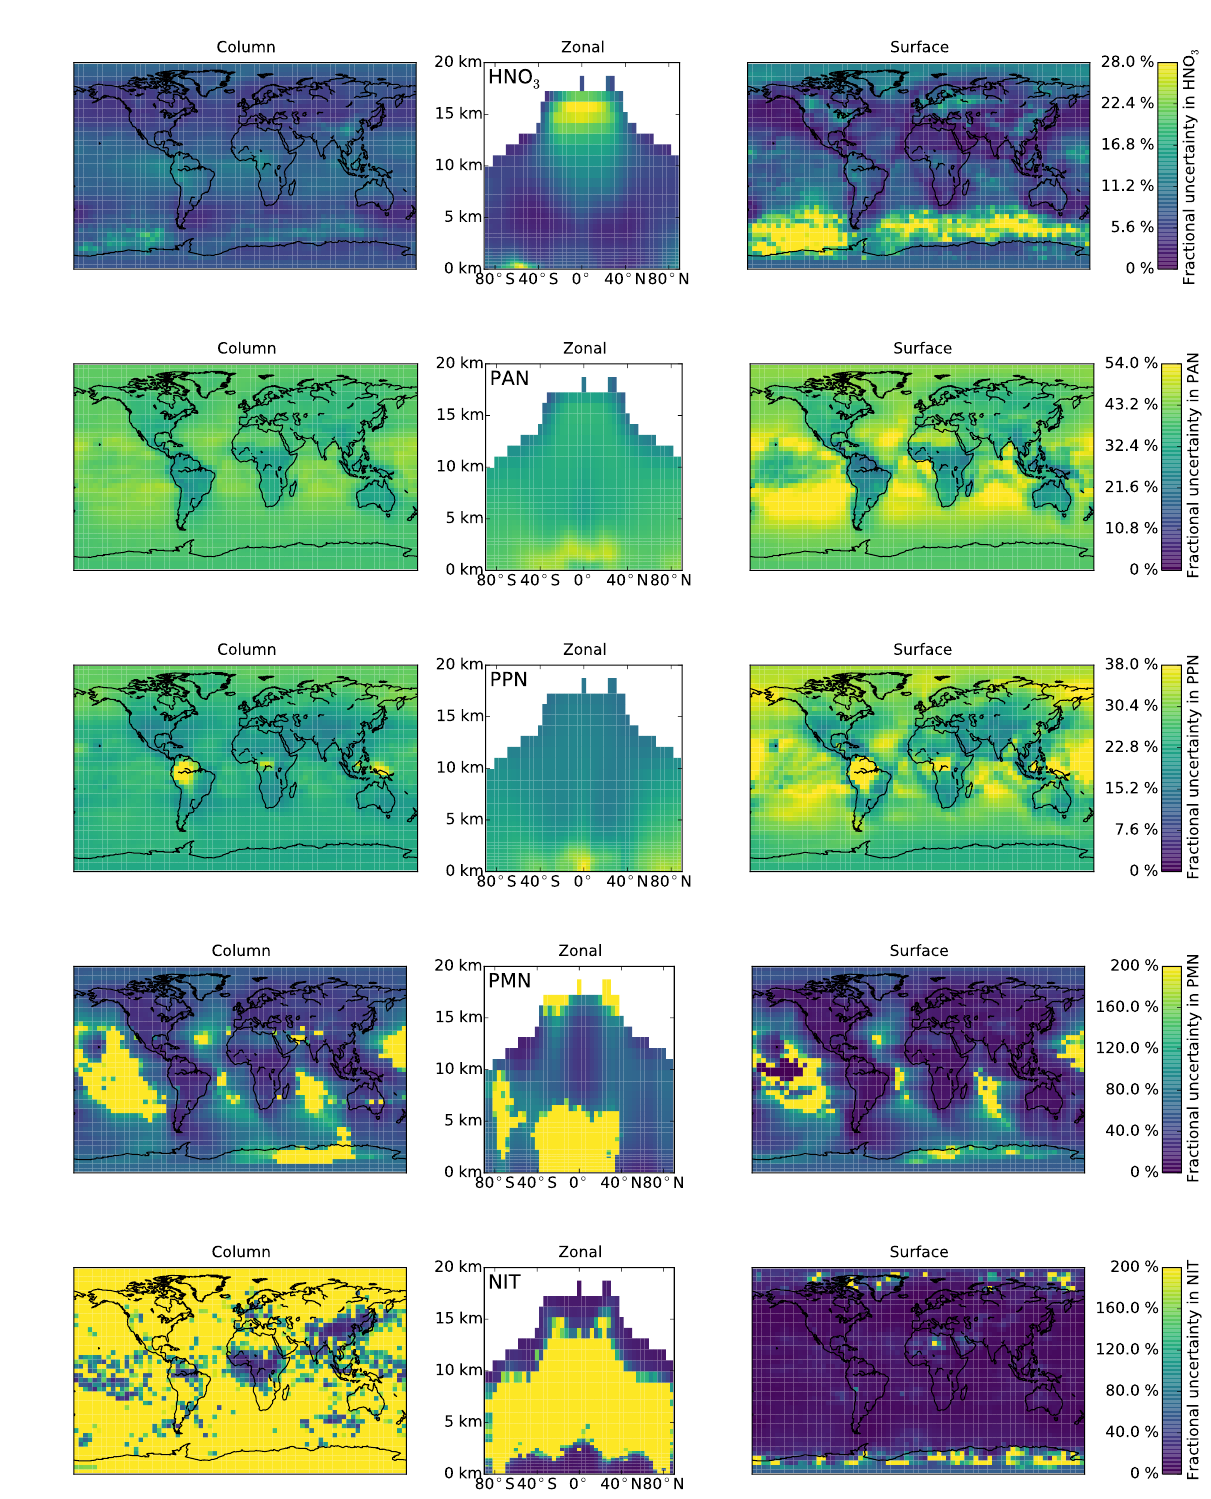
Figure 9. NO y : total 1 σ uncertainty in the concentrations of HNO 3 , PAN (peroxyacetyl nitrate), PPN (peroxymethacryloyl nitrate), PMN (peroxymethacryloyl nitrate) and NIT (inorganic aerosol nitrates) from the addition in quadrature of the individual reaction uncertainties. “Column” covers the tropospheric